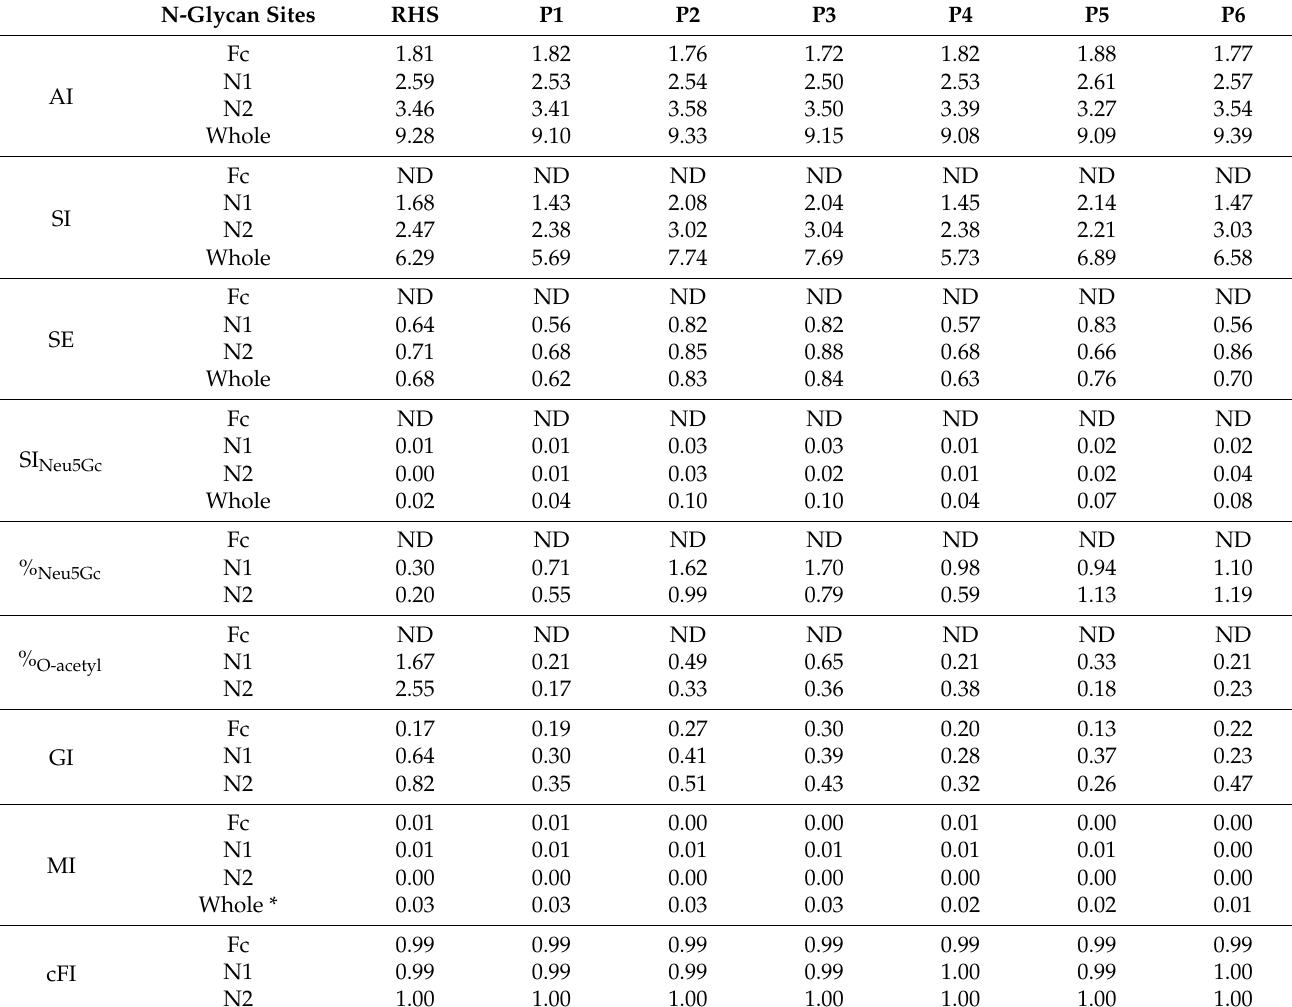
Table 6. Modulation of glycan-related CQAs during Process Optimization. P1–P6 represent different process conditions. Indices considered relevant for the whole molecule/domains are calculated and shown in the table.